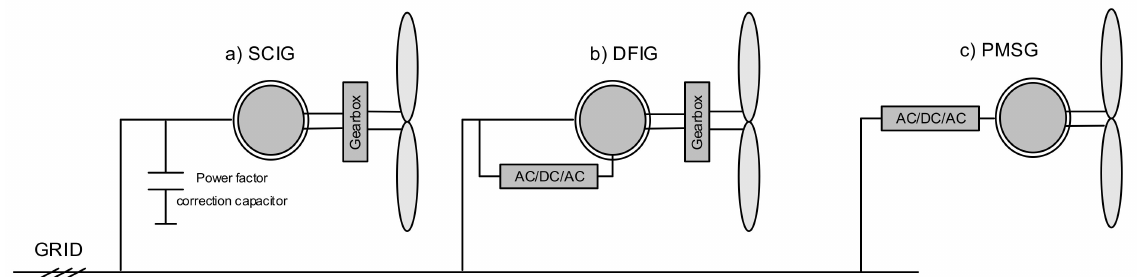
Figure 3. SCIG, DFIG and PMSG Wind Turbine Generators